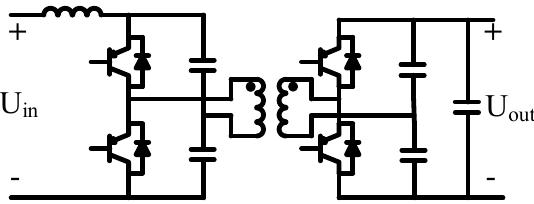
Figure 10. Topology of isolated full-bridge bidirectional DC/DC converter. The isolated half-bridge bi-directional DC/DC converter replaces some of the switch- ing tubes of the full-bridge circuit with a neutral point clamp capacitor. Compared to full-bridge converters, they require a higher current capacity of the power device and a higher support capacitance, making them suitable for medium and high-power applications. The structural diagram of an isolated half-bridge bi-directional DC/DC converter is shown in Figure 11.